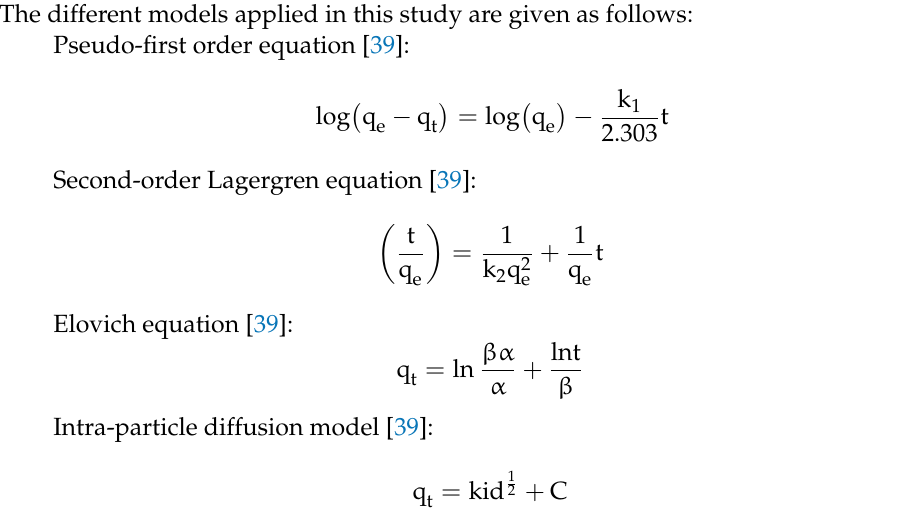
Figure 7. Adsorption kinetics for the adsorption of AO-8 Pd-Ni/AC-CeO 2 . A number of kinetics models are used to explain the kinetics of adsorption